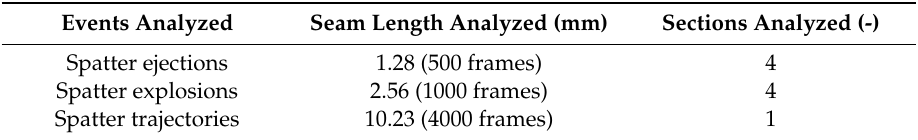
Table 1. Analysis of spatter